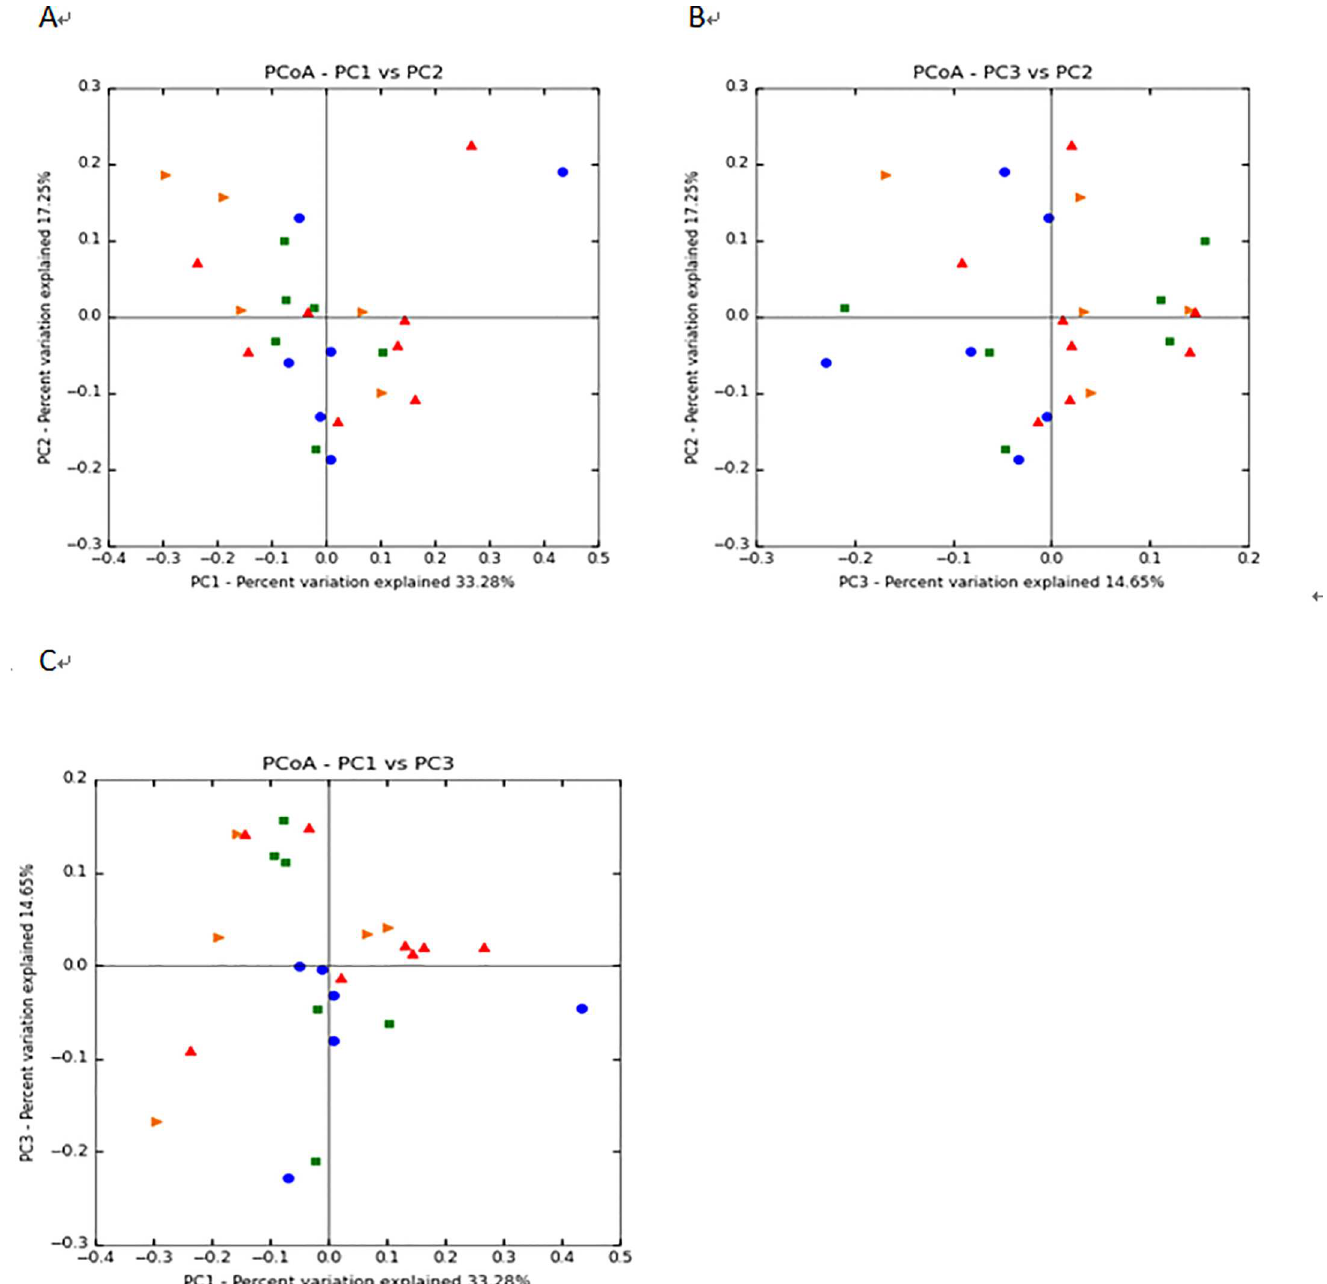
Fig 2. PCoA based on the UniFrac distance metric. To evaluatesimilaritiesbetweenbacterialcommunities, graphs A, B, and C were generatedusing OTUs, basedon the UniFrac distancemetrics PC1 and PC2, PC3 and PC2, and PC1 and PC3 (on a two-dimensional array), respectively.Samples from each treatment group are represented as follows: ► , HN45; ■ , HN75; ▲ , LN45; and ● , LN75. HN45 and HN75 represent samples obtained from Huanjiang mini-pigs fed the higher-nutrient diet for 45 and 75 days, respectively. LN45 and LN75 indicatesamples obtained from those given the lower-nutrient diet for 45 and 75 days,